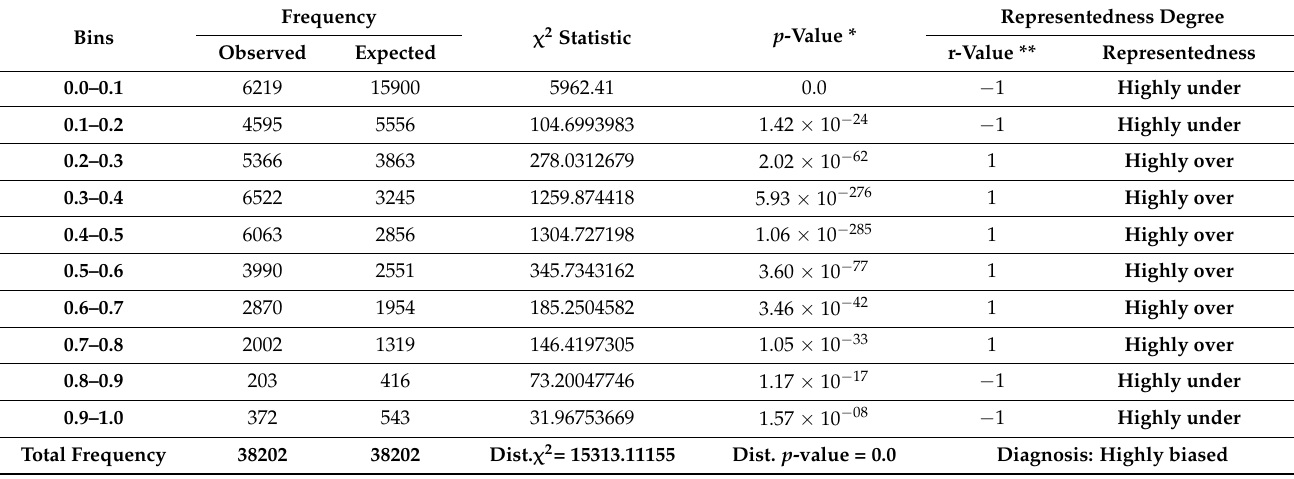
Table 4. Pearson’s χ 2 test results with percentage of cropland variable.